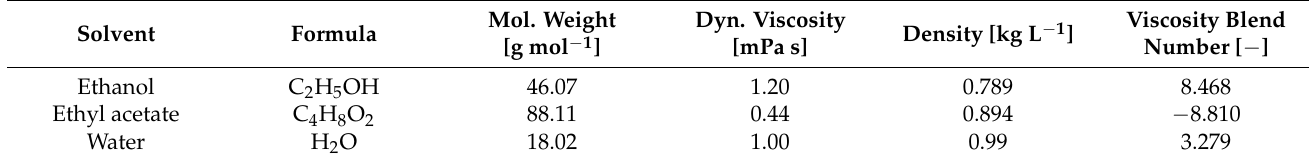
Table 1. Physicochemical properties of the used